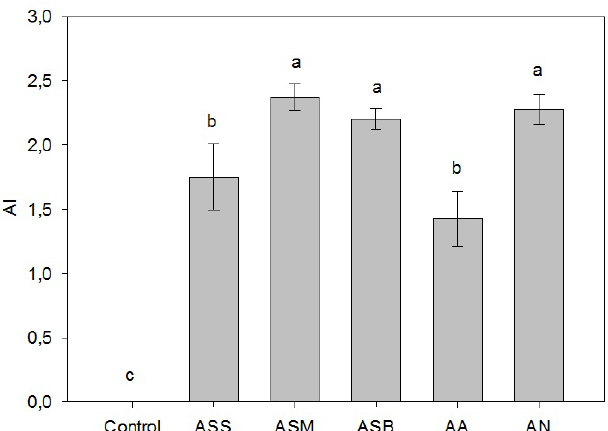
Fig 1. Aggressiveness index (AI) resulting from observed behaviors during interactions among workers of A. subterraneus subterraneus and conspecific nestmate workers (Control), conspecifics collected from a colony in the field (ASS), workers of A. subterraneus molestans (ASM), A. subterraneus brunneus (ASB), queens of A. ameliae (AA) or workers of A. niger (AN) with their standard errors. Different letters indicate significant differences by post hoc Fisher test